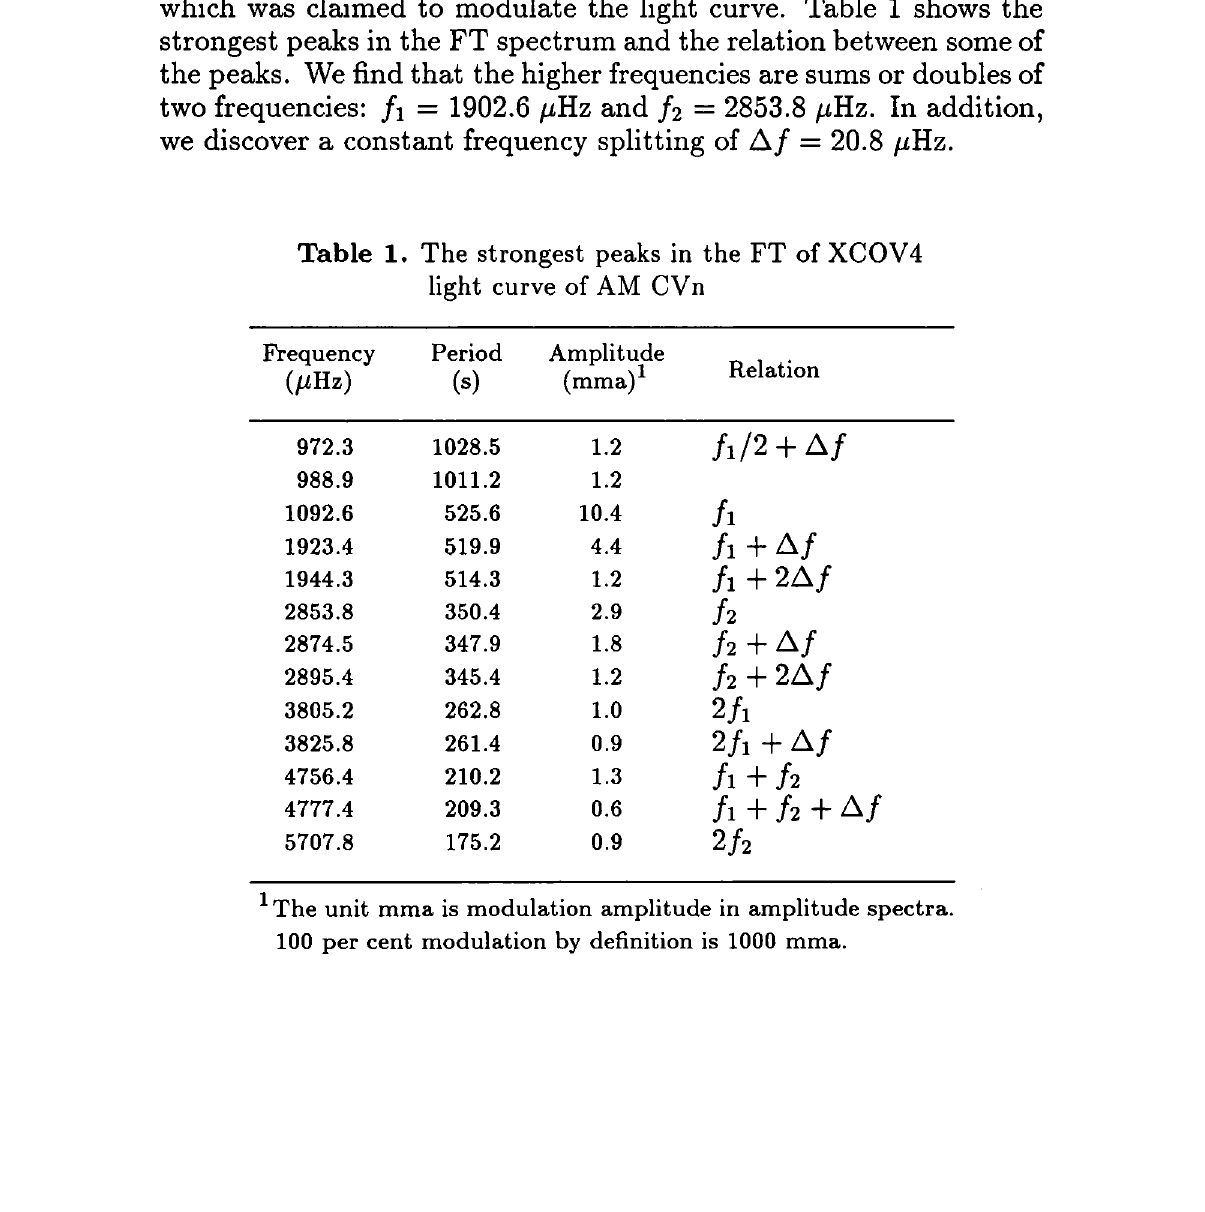
Table 1. The strongest peaks in the FT of XCOV4 light curve of AM